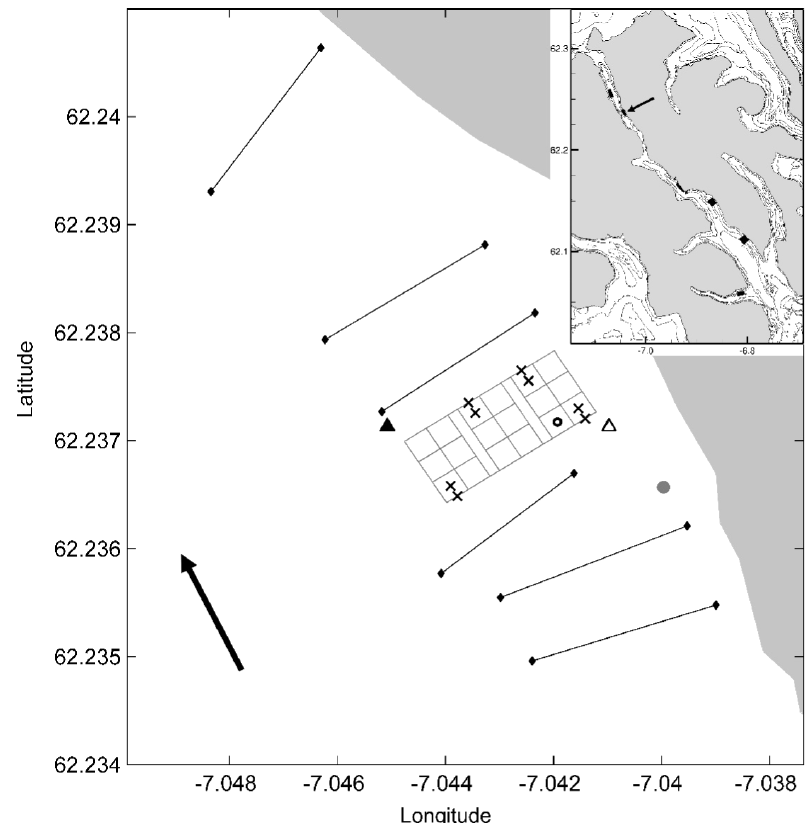
Fig. 1. Location of sampling stations and the fish farm in Sundalagið strait (~38 km long), Faroe Islands. At the farm, plankton was sampled by a plankton pump at 1, 4, and 6 m depth in the temporal study (position indicated by s ), and at 1 m depth in the spatial survey (positions indicated by + ). Around the farm, samples were taken by towing a plankton net ~180 m parallel to the farm (black lines with diamonds, just below the surface. The triangles outside the farm show the locations of the current meter at the spatial ( m ) and the temporal ( n ) survey, and the arrow indicates the main current direction at the positions of the current measurements. The position and size of the feed barge is shown in grey. Inset: Location of the study area in relation to Sundalagið. Fish farming areas are shown as black areas, and an arrow points to the studied farming